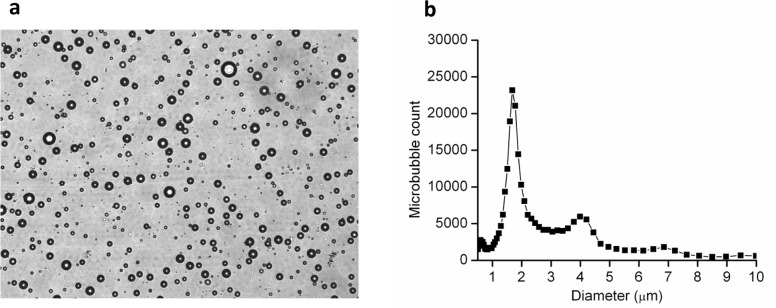
Morphologic characterization and size distribution of RGD-MBs.(a) Representative microscopic image of RGD-MBs (bar = 10 μm). (b) Typical size distribution of RGD-MBs.